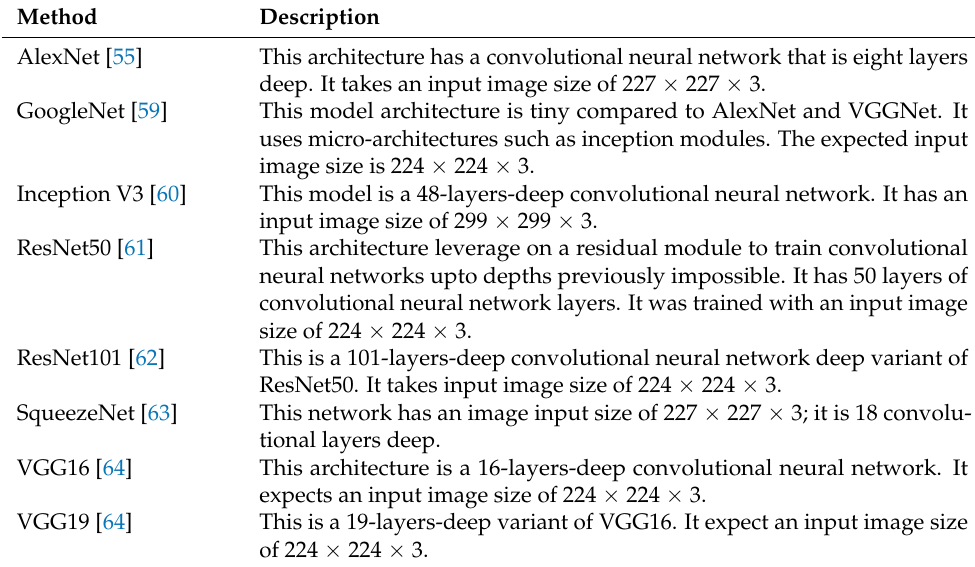
Table 1. List of the ImageNet pretrained models optimized for feature extraction and insect classifiers. Method